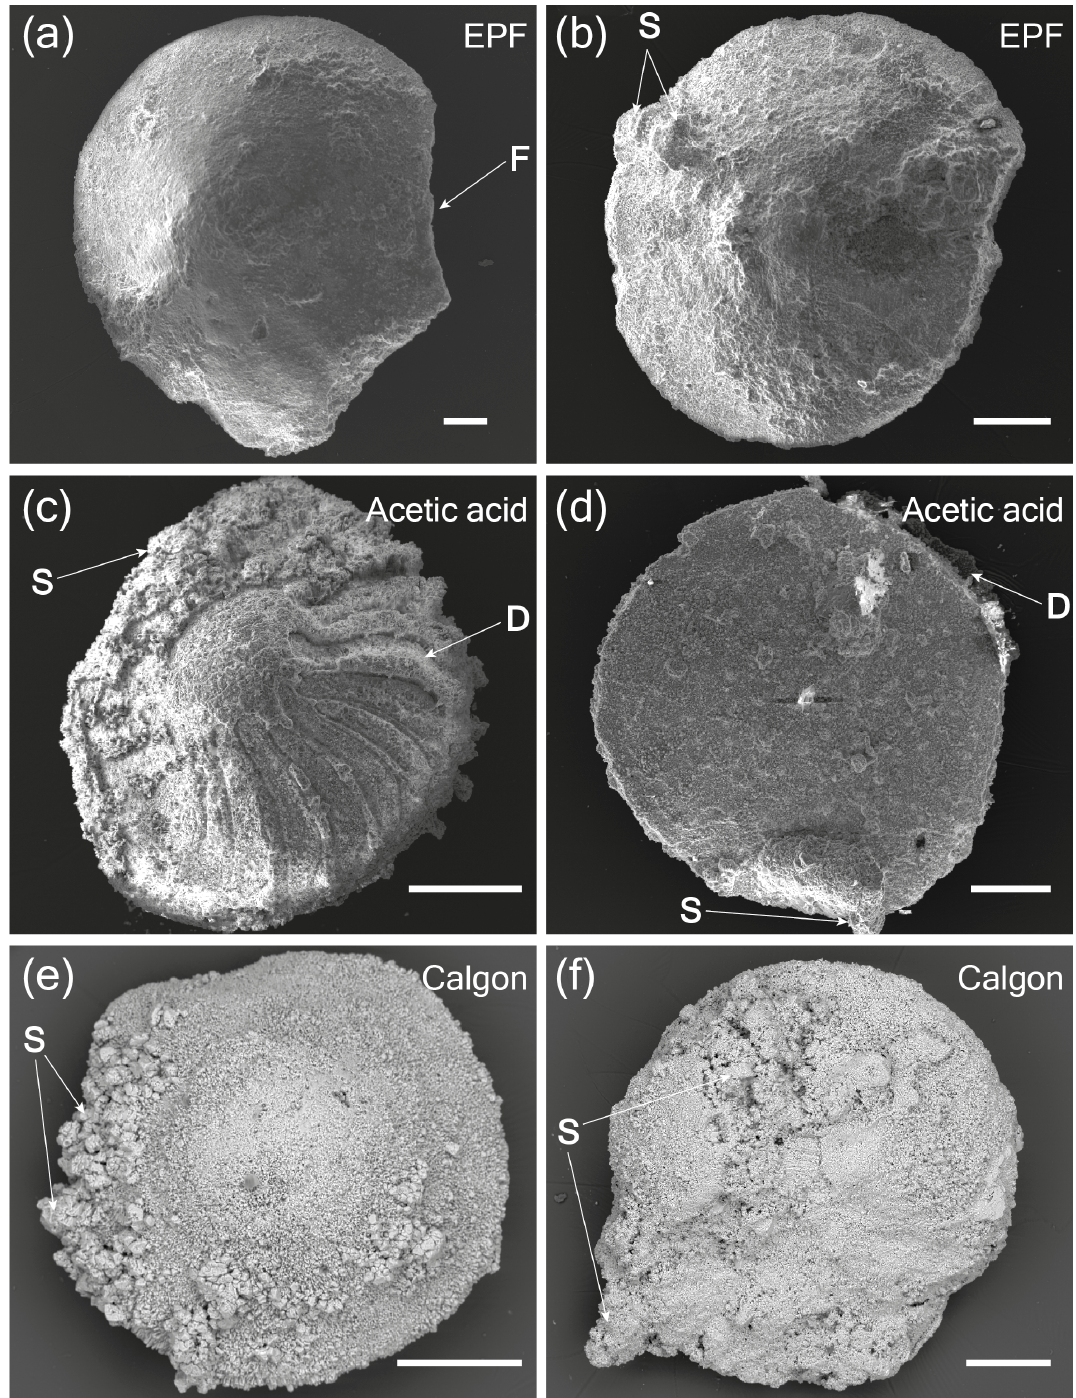
Figure 7. SEM and reflected light microscope images of select larger foraminifera from samples to show differential preservation from each technique. SE means that the image was taken in secondary electron mode. BSE means that the image was taken in backscattered electron mode. (a) K05 processed using EPF (SE) where some fragmentation (breakage) of specimen has occurred. (b) LCL processed using EPF (SE) where small amounts of sediment remain attached to the test surface. (c) K05 processed using acetic acid (SE) where dissolution has caused exposure of the internal chamber walls. (d) LCL processed using acetic acid (SE) where dissolution degraded the periphery of the test. (e) K05 processed using Calgon (BSE) where clumps of sediment remain attached to the test surface. (f) LCL processed using Calgon (BSE) where the test surface is obscured by large amounts of sediment remaining attached to the surface. Scale bars are 200µm. S signifies sediment remaining attached to test surface, D signifies dissolution of the test surface and F signifies fragmentation of the